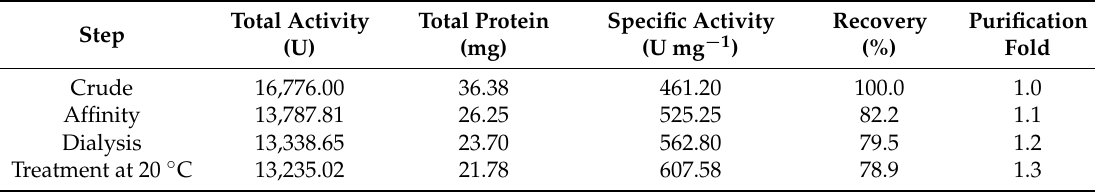
Figure 3. Gel electrophoresis analysis of mature rHZ lipase. ( a ) SDS-PAGE analysis of rHZ lipase after treatment at 20 °C and centrifugation. Lane M: Protein marker, lane 1: fraction no. 12 of affinity chromatography, lane 2: fraction no. 13 of affinity chromatography. ( b ) Native-PAGE analysis of purified rHZ lipase. Table 1. Summary of purification of rHZ lipase.